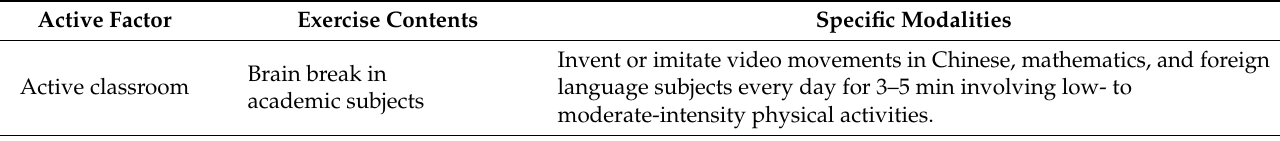
Table 3. The specific contents of the KDL-ASP.